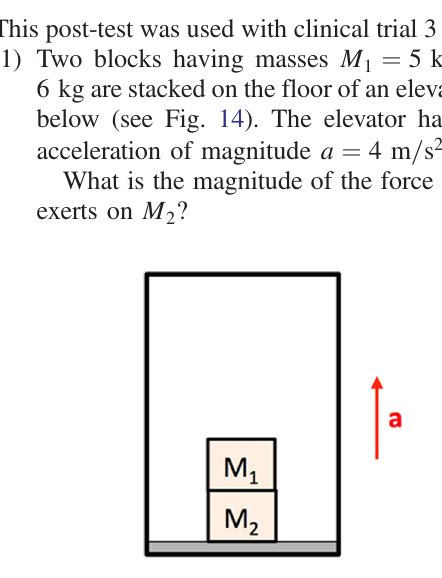
FIG. 14. Figure for Newton ’ s laws post-test problem 1.